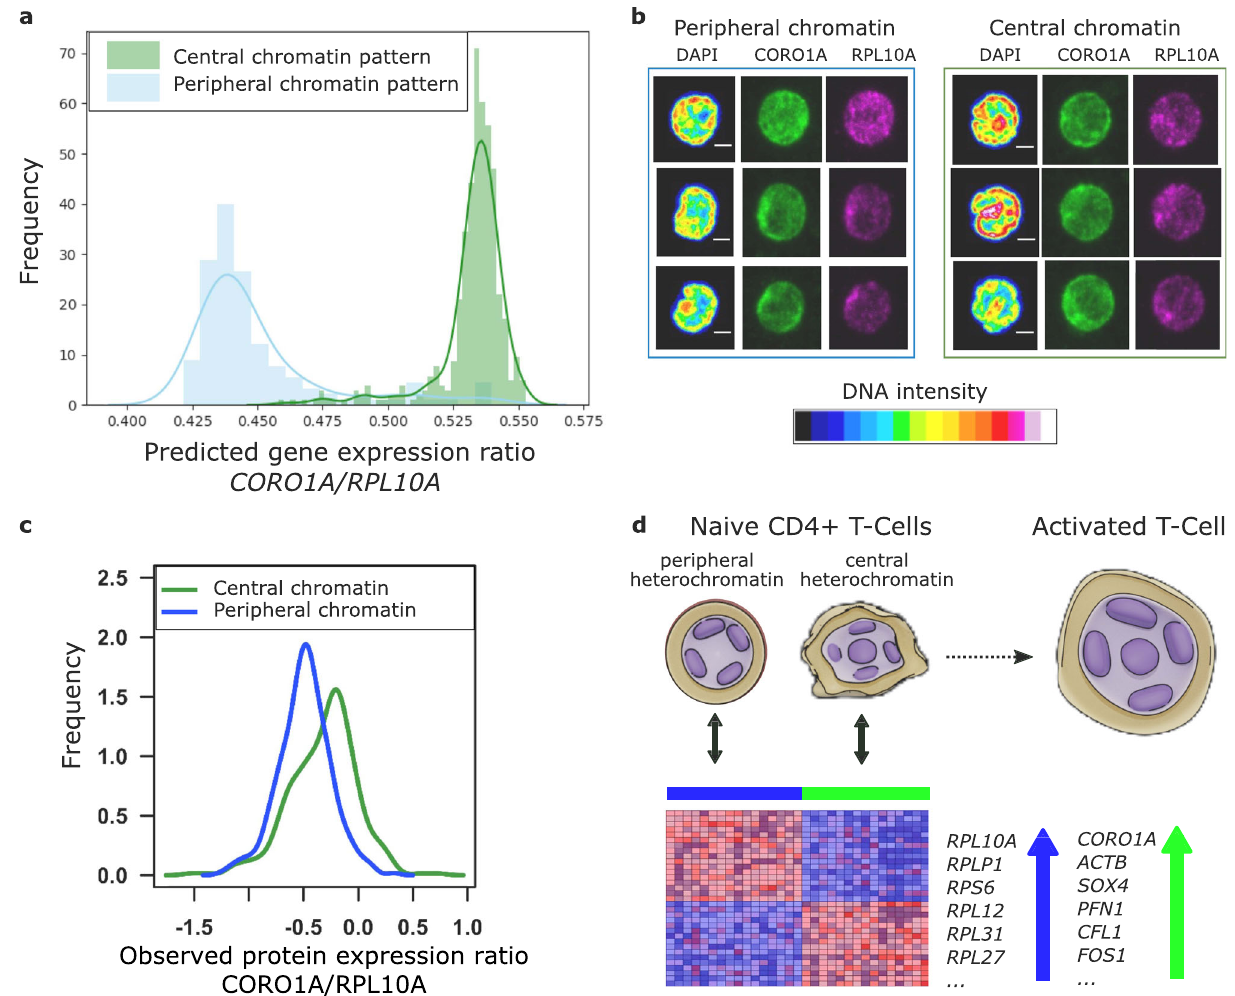
Fig. 5 Validation of our model alignment using single-cell immuno fl uorescence experiments. a Histograms of predicted CORO1A/RPL10A gene expression ratio in cells with central (green) and peripheral (blue) chromatin pattern based on the gene expression matrix translated from the imaging dataset. Our model predicts the upregulation of CORO1A and RPL10A in the cells with central and peripheral chromatin patterns respectively. b Examples of immuno fl uorescence staining data of CORO1A and RPL10A proteins collected along with the chromatin images. c Histograms of measured CORO1A/ RPL10A protein ratio in cells with central (green) and peripheral (blue) chromatin pattern. Consistent with the model prediction, CORO1A and RPL10A proteins are upregulated in the cells with central and peripheral chromatin patterns respectively ( p -value < 2.2 × 10 − 16 , two-sided Welch ’ s t -test). d Schematic of the two naive T-cell subpopulations characterized by our multimodal analysis, in which peripheral and central patterns of chromatin density are associated with gene expression programs for quiescent (blue) and poised (green) naive CD4 + T-cells respectively. The up and down arrows represent which genes are upregulated and downregulated respectively as predicted by our